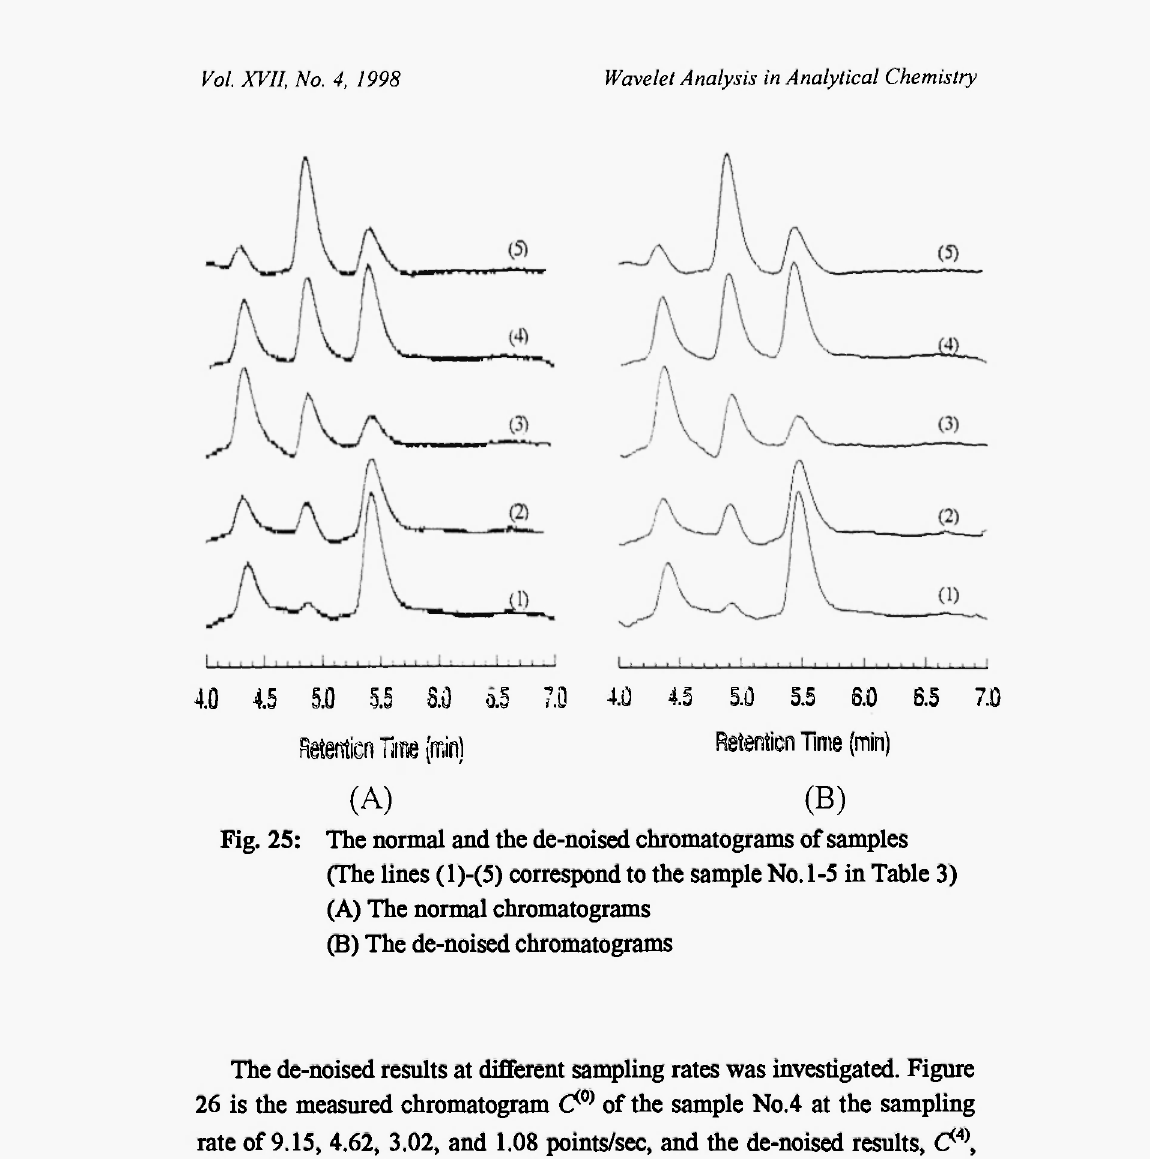
Fig. 25: The normal and the de-noised chromatograms of samples (The lines (l)-(5) correspond to the sample No. 1-5 in Table 3) (A) The normal chromatograms (B) The de-noised